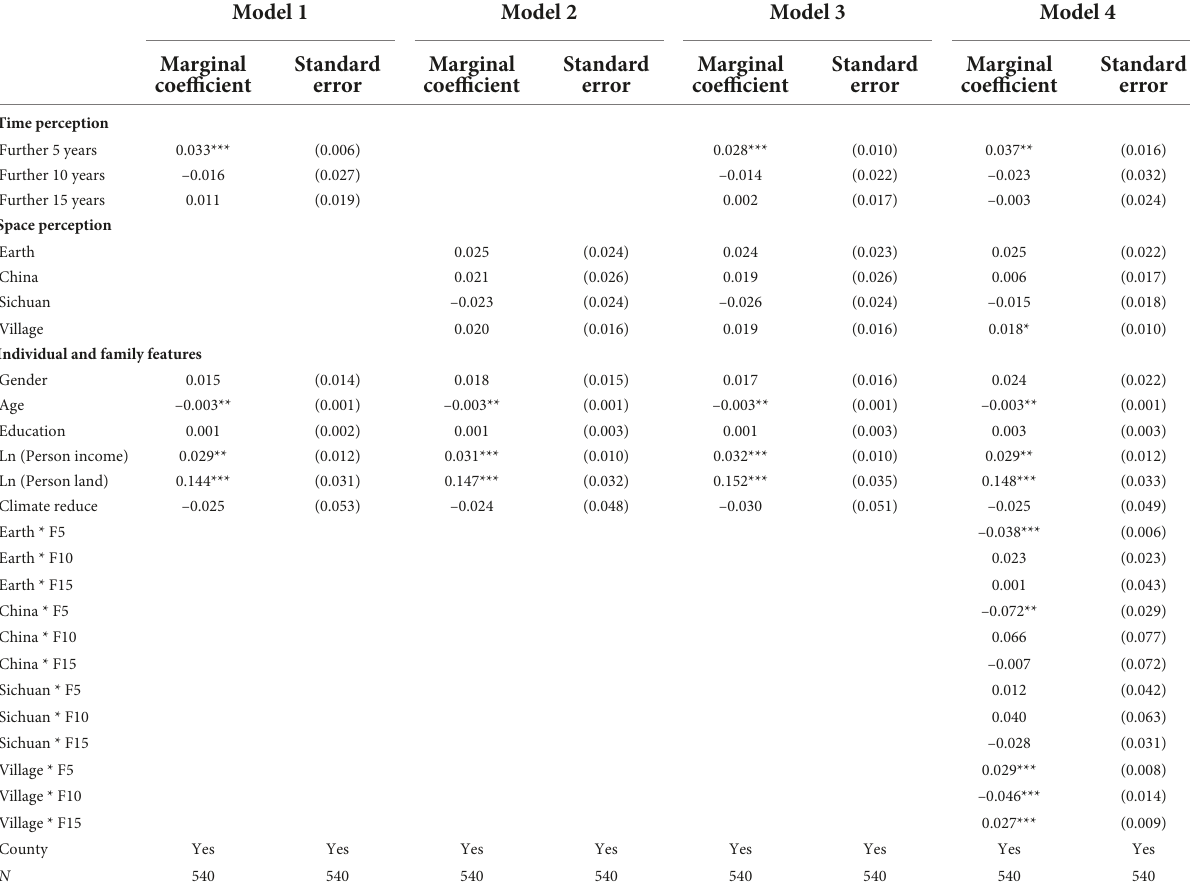
TABLE 3 Logit regression results of space-time perception and moderating effect of farmers’ climate